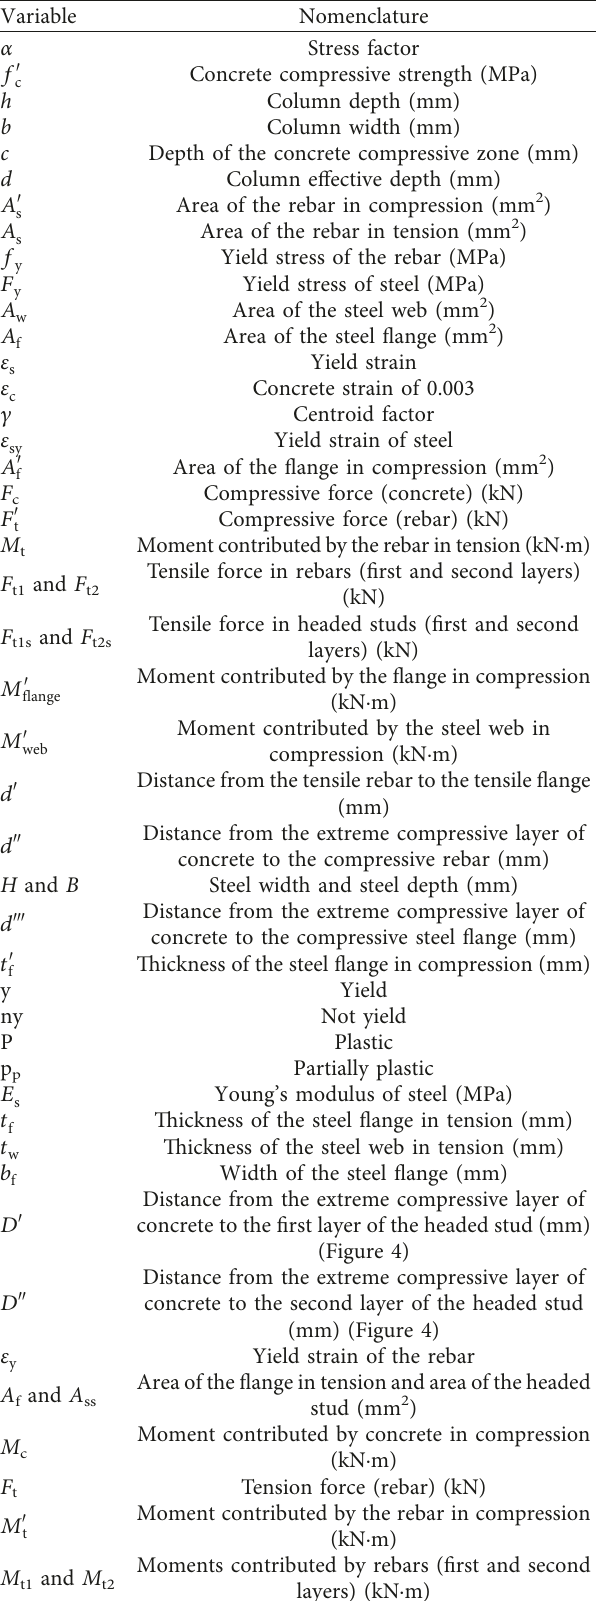
Table 4: Variables used in equations (1), (3), (4), and (6)–(11) and Tables 5–7